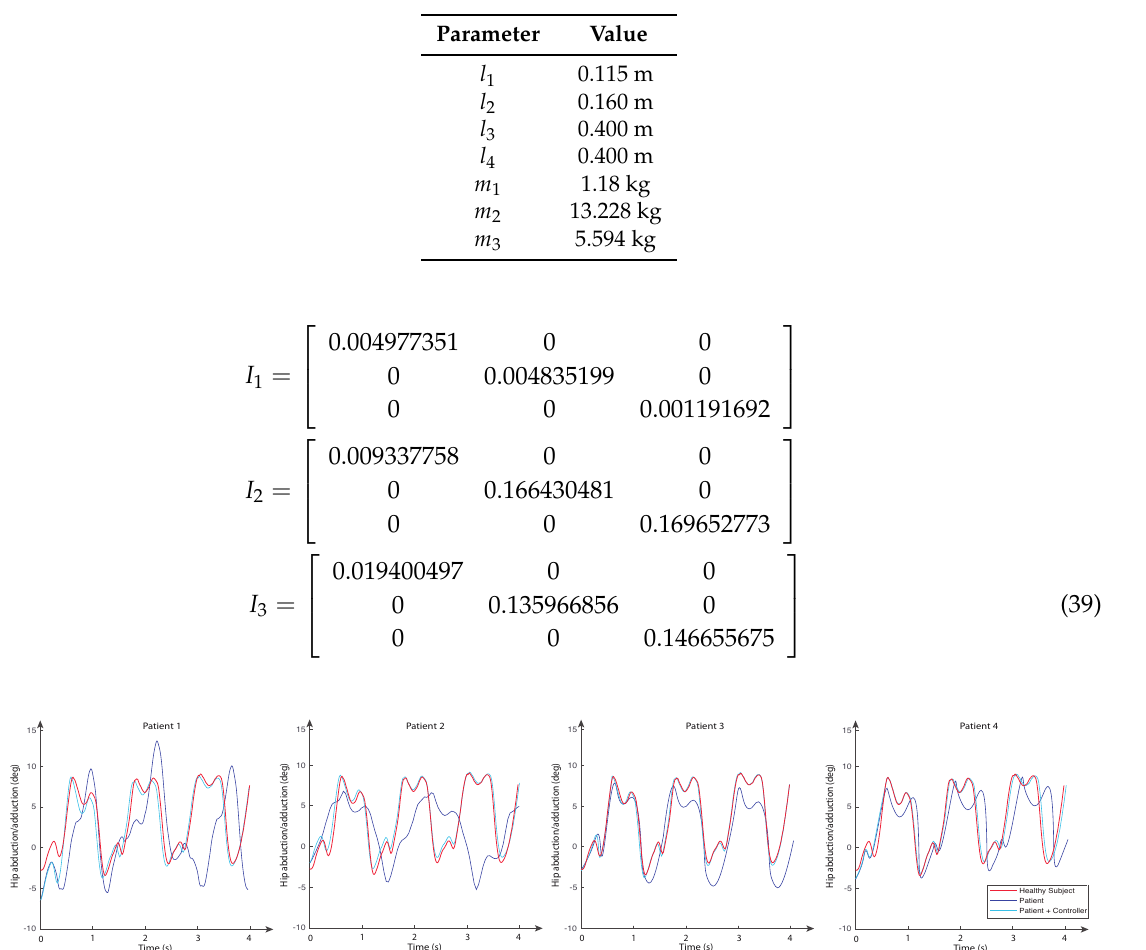
Table 4. ALICE length and mass values.